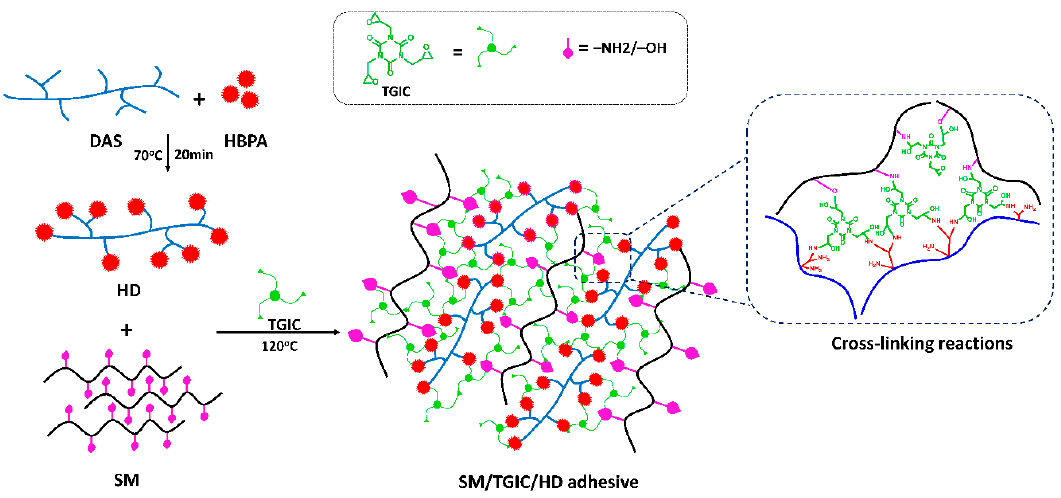
Figure 3. The attenuated total reflectance- f ourier transform infrared spectroscopy (ATR-FTIR) spectra of the resulting adhesives.